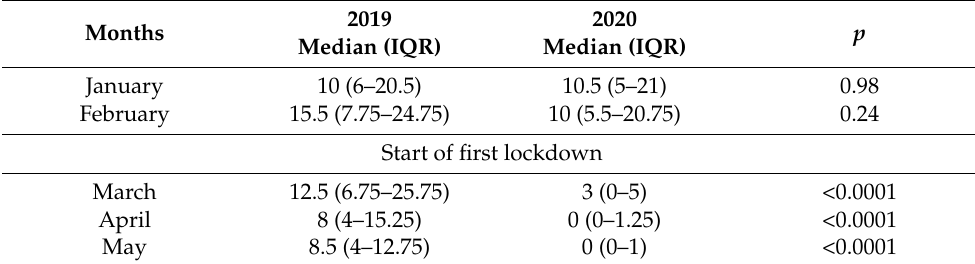
Table 5. Number of patients with otitis recorded monthly in 2019 compared to 2020, in the study population of 35,787 children aged 0–14